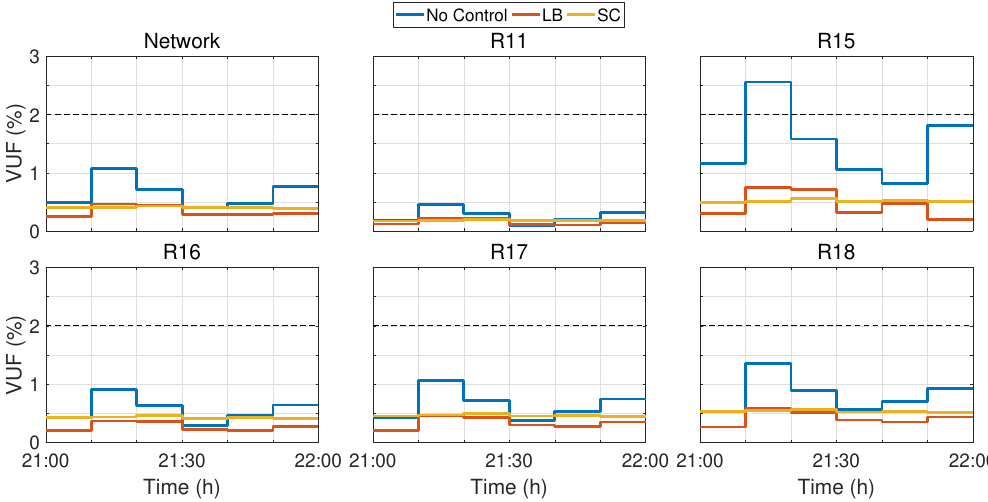
Figure 12. VUF for Scenarios IV, V, and VI.